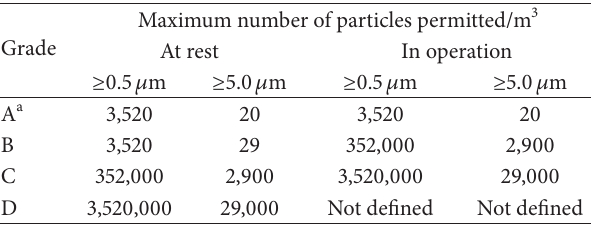
Table 3: Airborne particulate classification for these grades, accord- ing to the PIC/S GMP and